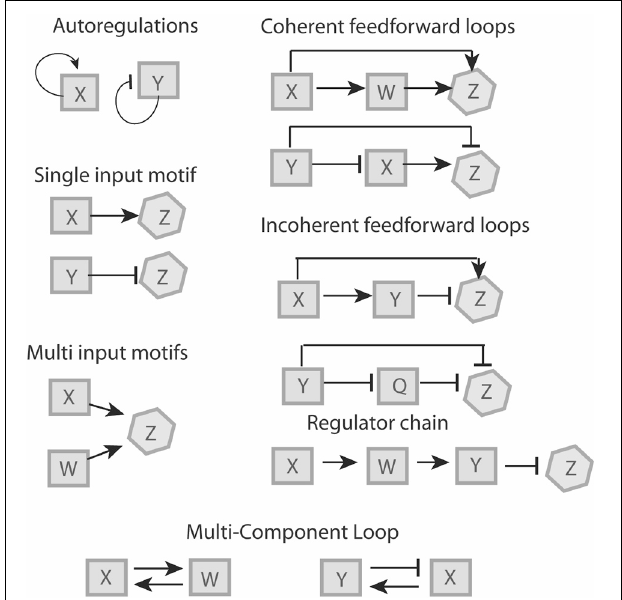
FIGURE 1 | Regulatory features. Proteins “X” and “W” are positive regulators, proteins “Y” and “Q” are negative regulators and protein “Z” is a non-regulator. All six motifs represented can be recognized in L. monocytogenes (see Figure 2 ).